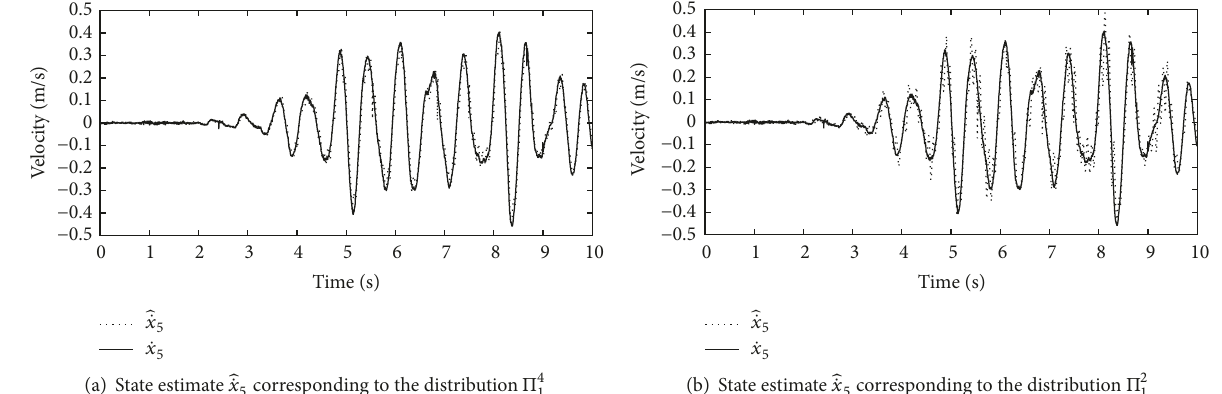
(b) State estimate ̂̇𝑥 5 corresponding to the distribution Π 2 1 Figure 13: Estimates produced by the state observer in the distributions Π 4 1 and Π 2 1 .